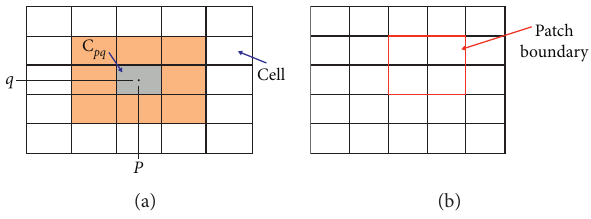
Figure 1: [44] Cell grid of (a), the colored contour of C